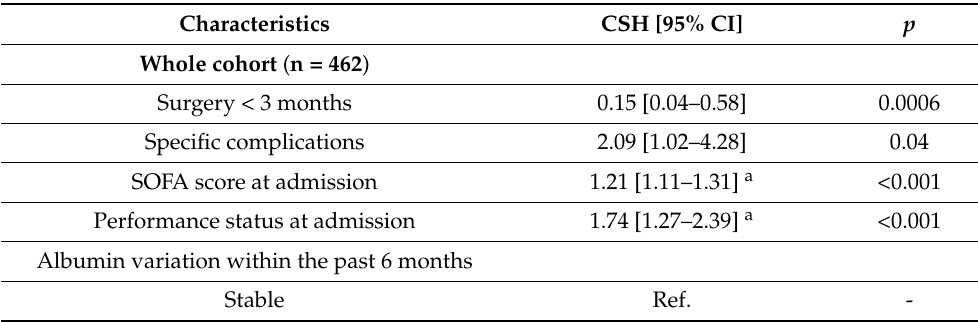
Table 3. Factors associated with ICU mortality in the whole cohort and in the subgroup of patients undergoing invasive mechanical